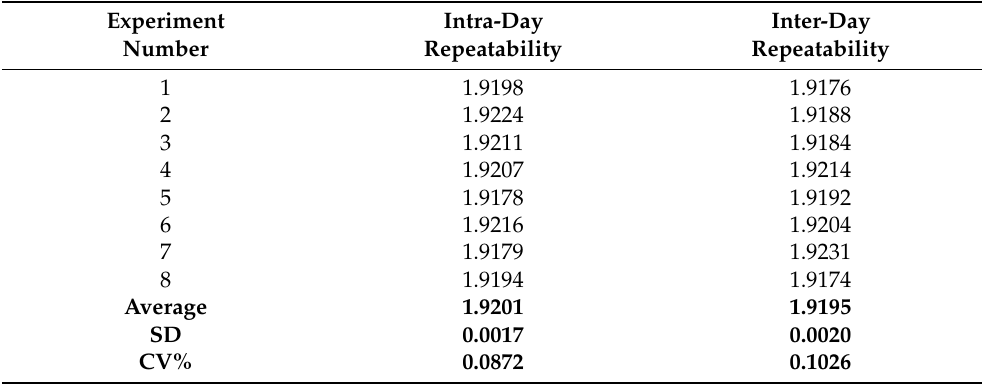
Table 4. The intra-day and inter-day repeatability (average value, SD; coefficient of variation, CV) of the applied method for the determination of Glc concentration in standard sample.